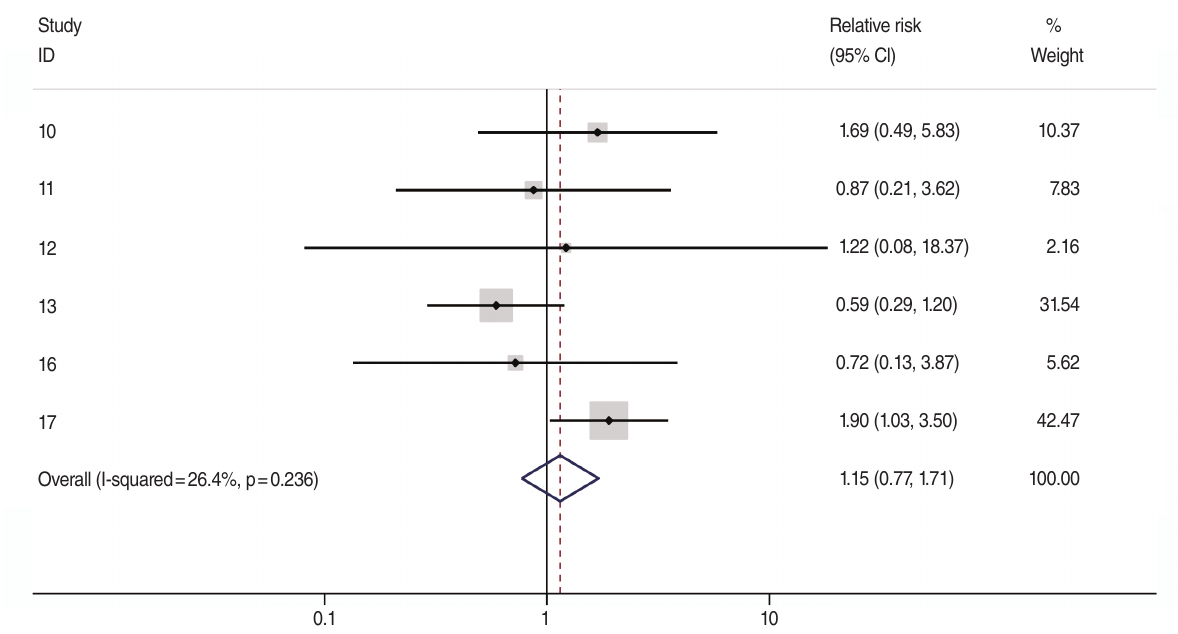
Figure 1. The forest plot of using a fixed-effects summary estimates in 6 cohort articles evaluating association between allergic history and pancreatic cancer risk. ID, reference number; CI, confidence interval.